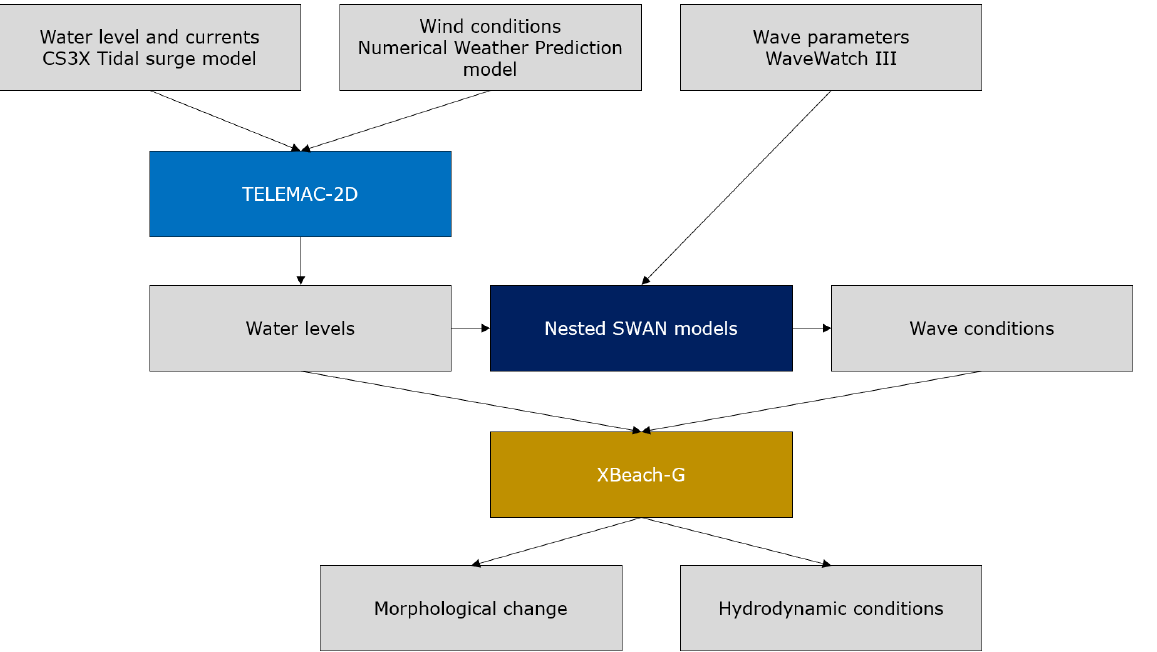
Figure 3. Numerical modeling framework displaying flow of data from TELEMAC-2D to nested SWAN models to XBeach-G outputs.